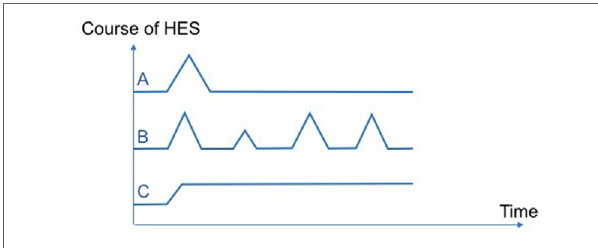
FiGURe 1 | Various patterns of disease courses observed in hypereosinophilic syndromes (HES). Pattern (A) : single flare without subsequent relapse. Pattern (b) : several relapses with intervals of complete remission. Pattern (C) : chronic persistent